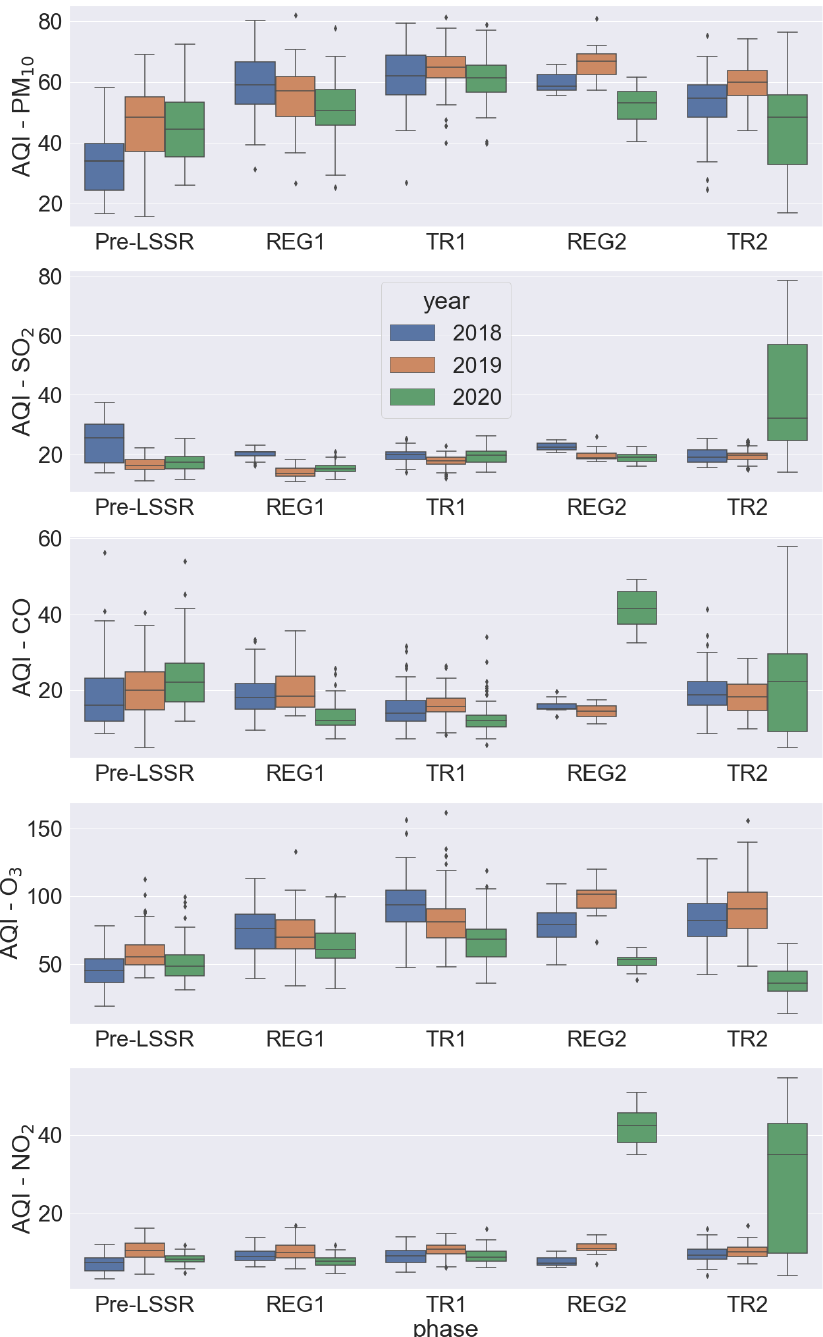
Figure 4. The AQI seasonal trend of PM 10 , SO 2 , CO, O 3 , and NO 2 in Jakarta in 2018, 2019, and 2020 grouped by the phases described in Section 2.2. The AQI was averaged over the five measured locations in